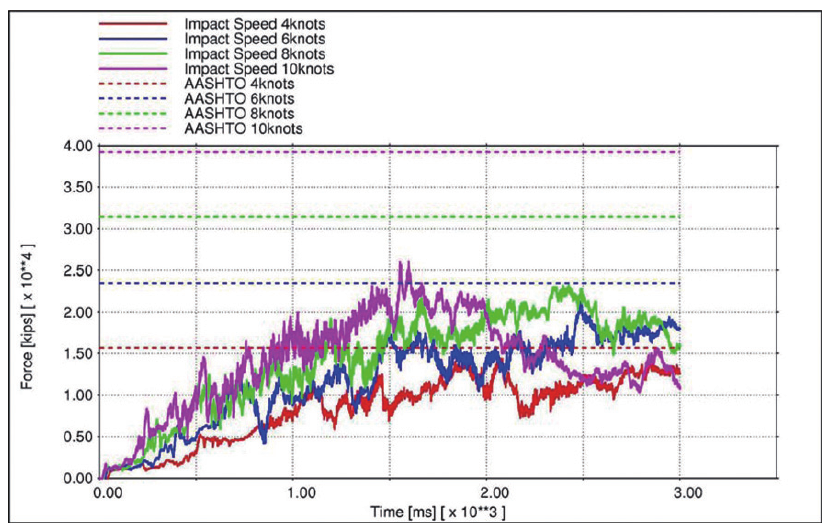
Fig. 4. Time history plots of the vessel crushing force for various impact forces – calculated using a detailed fi nite element ship